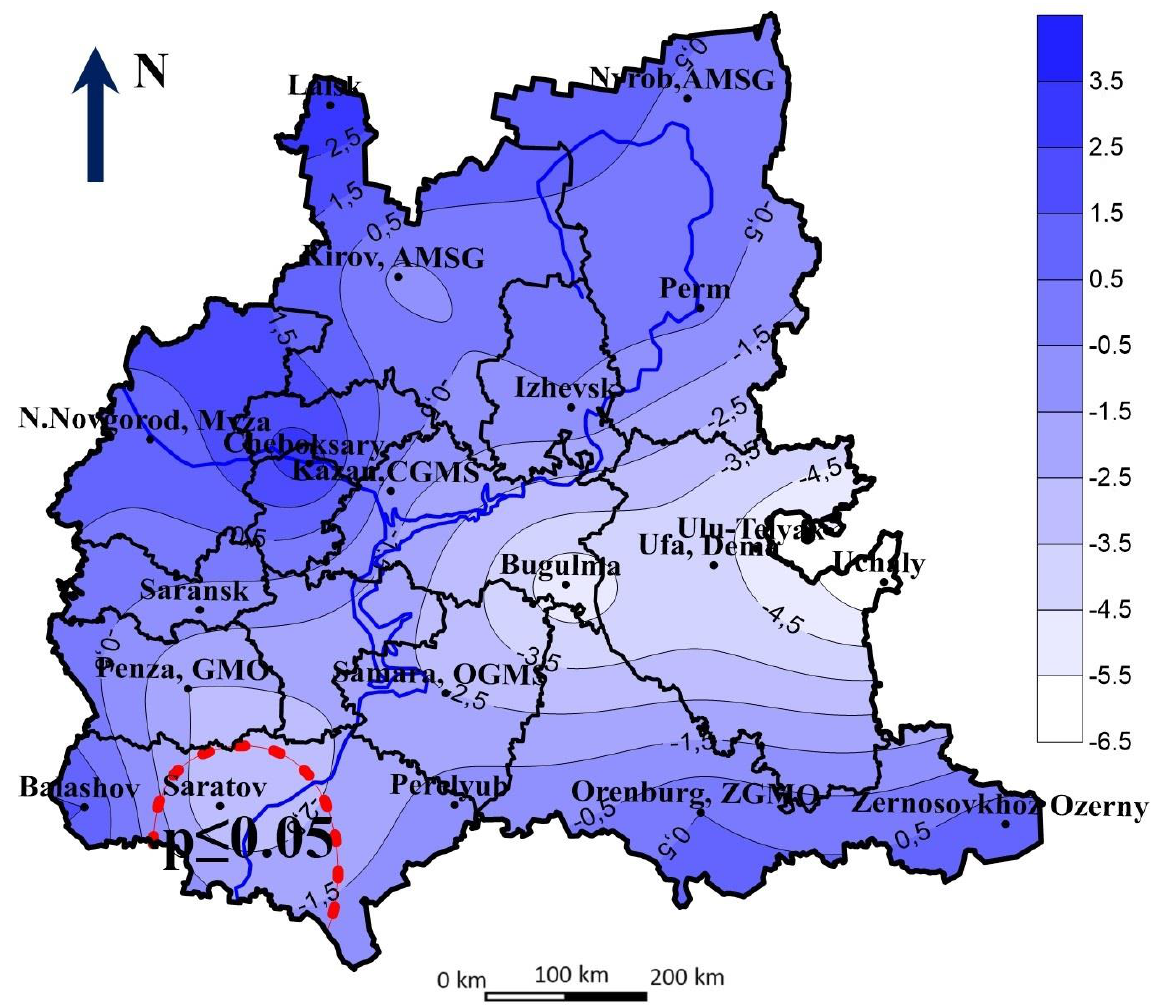
Figure A4. Linear trend slope coefficients (LTSC, mm/10 years) of July precipitation and their statistical significance in the Volga Federal District during 1966 – 2021.